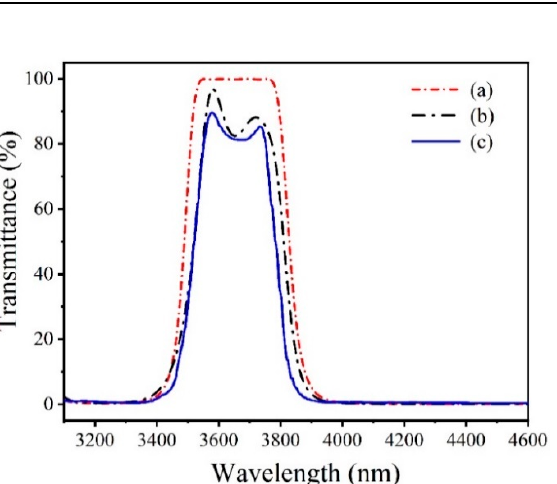
Figure 14. Computed and measured transmittance of the filter for comparison. ( a ) Theoretical spectrum, ( b ) simulated spectrum (simulated by applied actual thickness), and ( c ) measured spectrum .